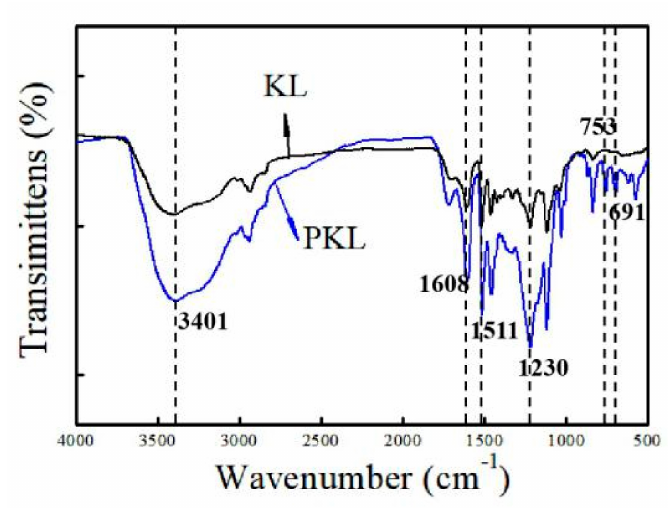
Figure 2. FT-IR spectra of KL and PKL.